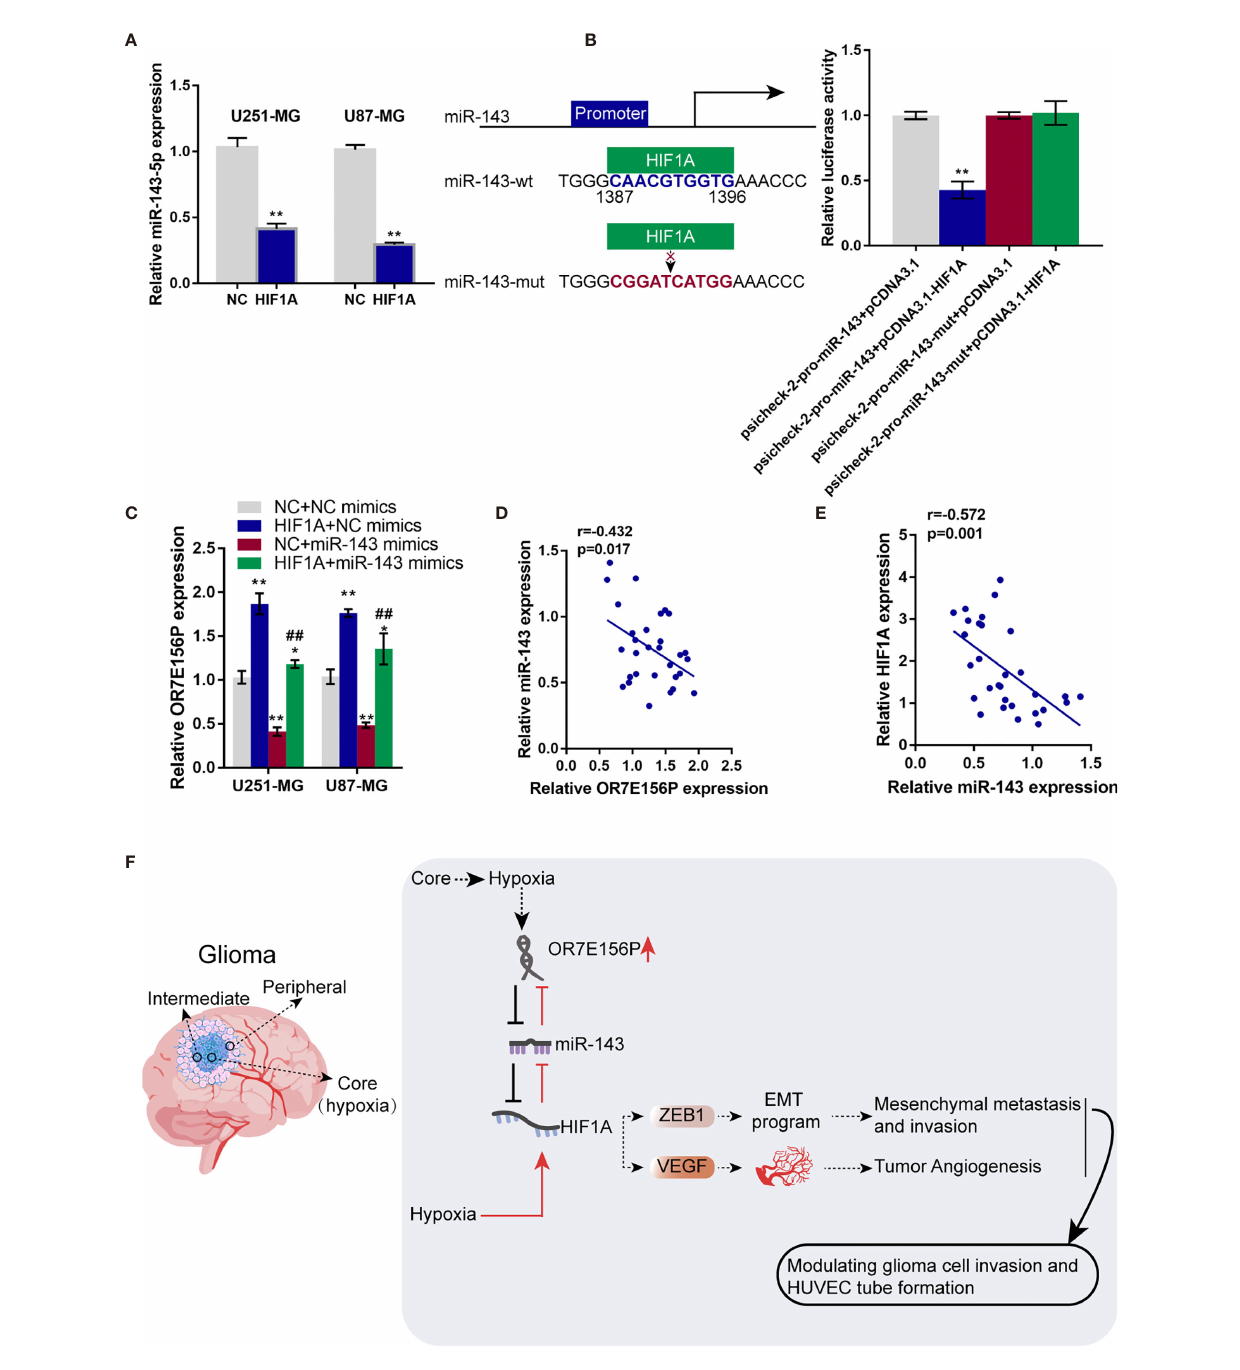
FIGURE 7 | HIF1A binds to the promoter region of miR-143 and inhibit miR-143 expression (A) U251-MG and U87-MG cells were transfected with NC or HIF1A overexpression vector and examined for the expression of miR-143 by qRT-PCR. (B) Wild- and mutant-type miR-143 promoter luciferase reporter vectors, psicheck- 2-pro-miR-143 and psicheck-2-pro-miR-143-mut, were constructed based on psiCheck-2 vectors. These vectors were co-transfected in 293T cells with pcDNA3.1/ HIF1A and the luciferase activity was determined. (C) U251-MG and U87-MG cells were co-transduced with NC or HIF1A overexpression vector and NC mimics or miR-143 mimics and examined for the expression of OR7E156P by qRT-PCR. (D, E) The correlation of miR-143, OR7E156P, and HIF1A expression in tissue samples was analyzed using Pearson ’ s correlation analysis. (F) A schematic diagram showing the process of the OR7E156P/miR-143/HIF1A axis modulating glioma cell invasion through ZEB1 and HUVEC tube formation through VEGF. ## p < 0.01, *p < 0.05, **p < 0.01, compared to psicheck-2-pro-miR-143+pcDNA3.1 or NC+NC mimics group; ## p < 0.01, compared to NC+miR-143 mimics